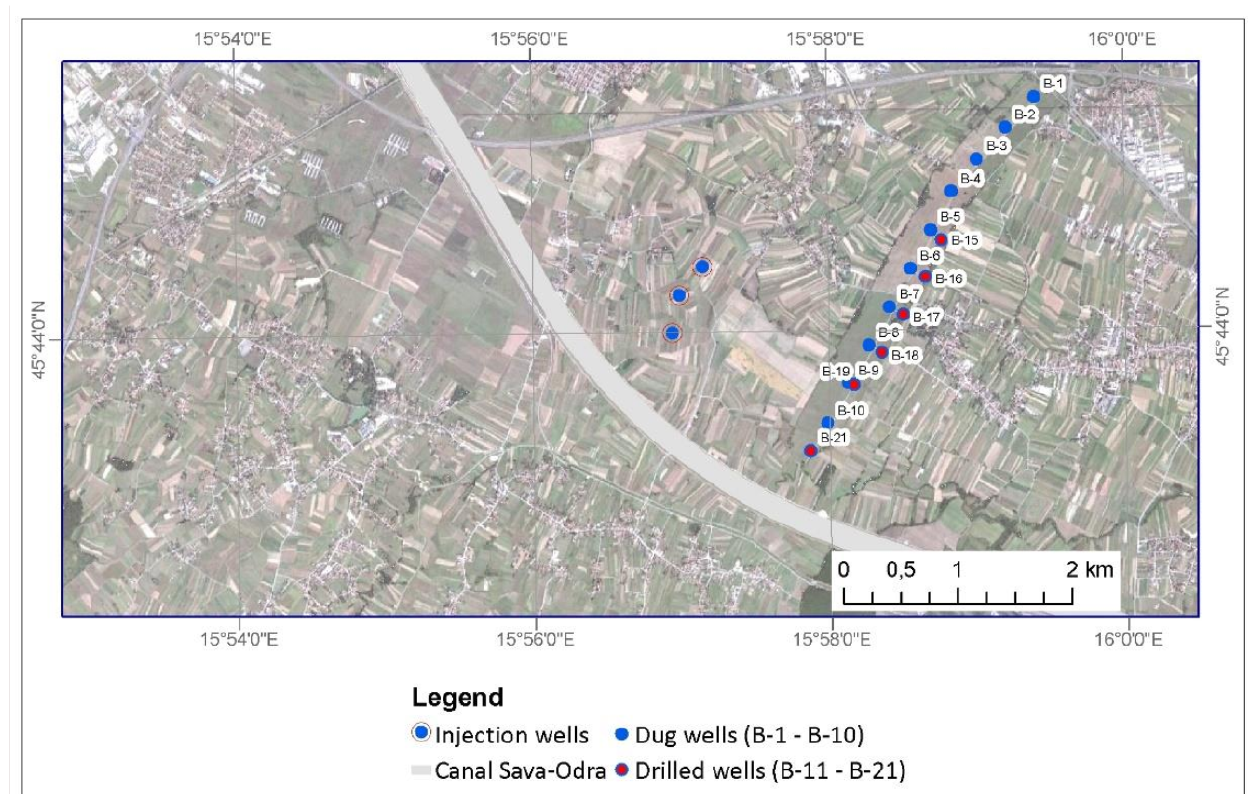
Figure 18. Position of the injection wells upstream from the Mala Mlaka water pumping station. Two variants of artificial recharge using a battery of three injection wells with